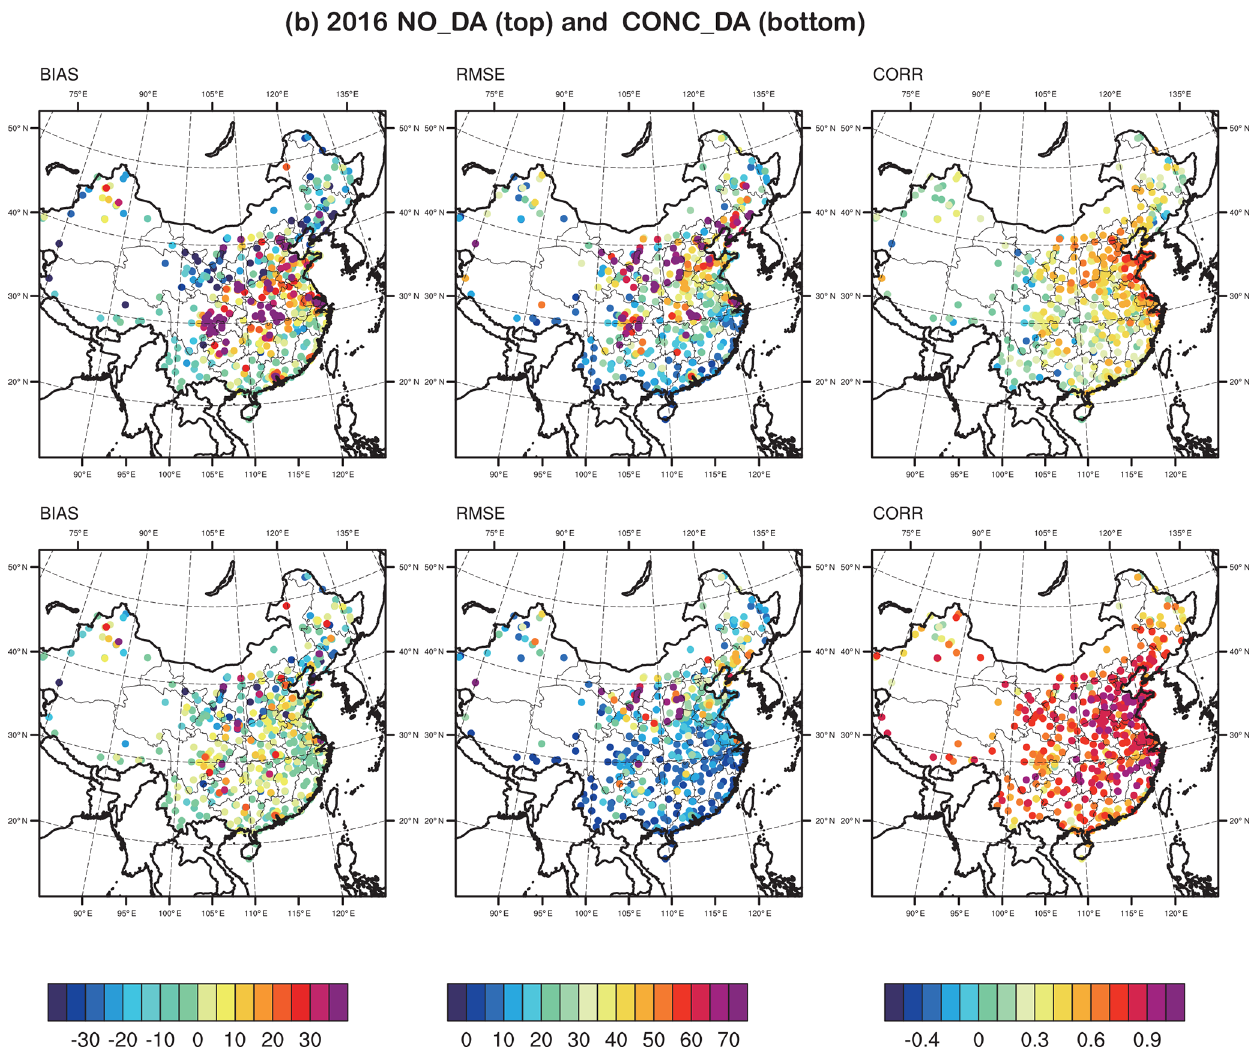
Figure 4. The spatial distribution of the statistics between the model simulations and the observations for (a) January 2015 and (b) Jan- uary 2016. The top row shows NO_DA vs. observations, whereas the bottom row shows CONC_DA vs. observations. (Units: µgm − 3 for BIAS and